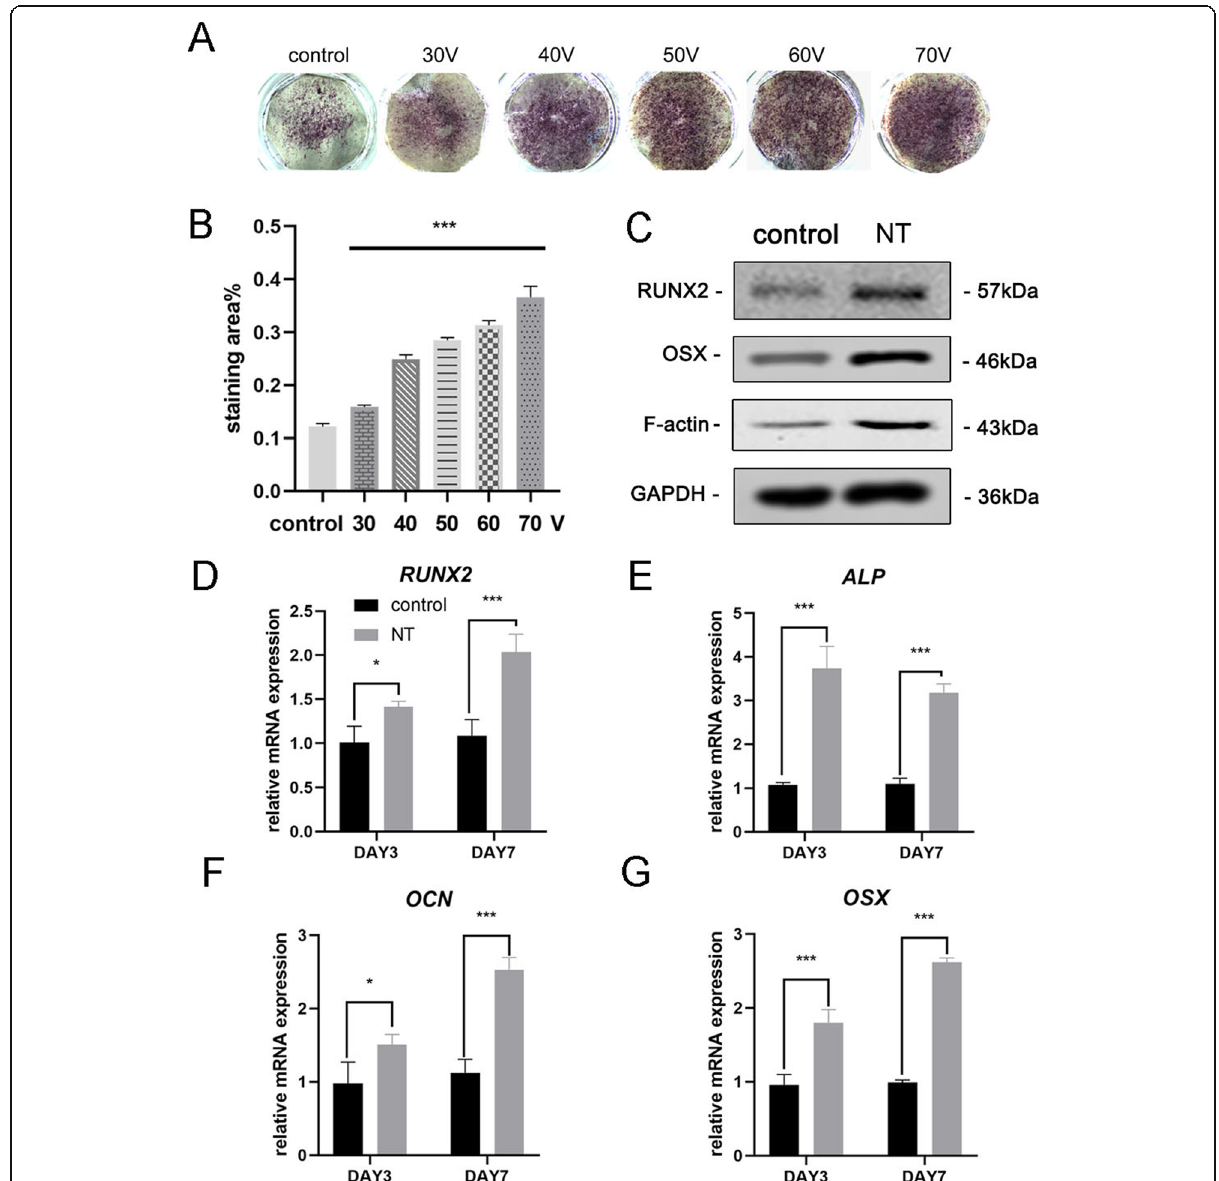
Fig. 3 TiO 2 nanotubes enhanced osteogenic gene expression of BMSCs. a ALP staining of the smooth titanium substrate and five different nanotube substrates. The cells were induced with osteogenic medium for 7 days. b Statistical analysis of the staining area was performed using ImageJ. c Osteogenesis-associated proteins (RUNX2, and OSX) and F-actin in MSCs were analyzed by Western blotting at day 7. The mRNA expression of RUNX2 ( d ), ALP ( e ), OCN ( f ), and OSX ( g ) at days 3 and 7, analyzed by qRT-PCR. NT the nanotube group. Data represent the mean ± SD of three samples. * P < 0.05, ** P < 0.01, and *** P <